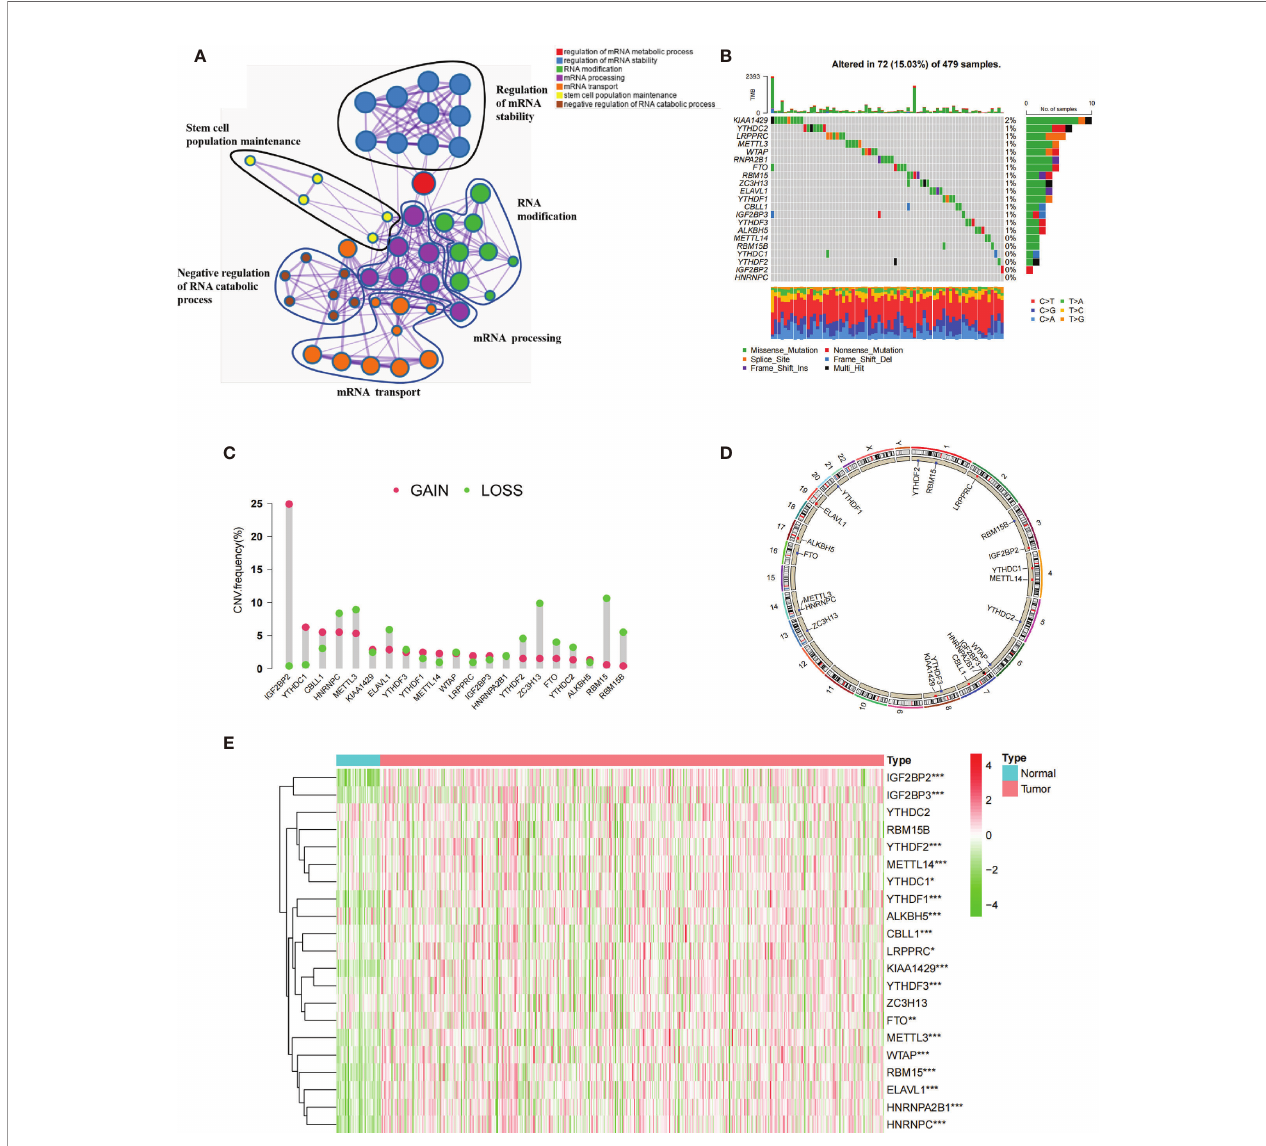
FIGURE 1 | The genetic landscape of 21 m 6 A regulators in HNSCC. (A) The functional enrichment network of 21 m 6 A regulators visualized by Metascape. Different circles represented different annotations. (B) Seventy-two of the 479 patients showed different genetic alterations, including missense mutation, splice site, and nonsense mutation. (C) The CNV of 21 m 6 A regulators. The column represented the alteration frequency. The green dots represented deletion of CNV. The pink dots represented ampli fi cation of CNV. (D) The location of CNV alteration of m 6 A regulators in cell. (E) The different expression level of 21 m 6 A regulators between normal and HNSCC (* p < 0.05; ** p < 0.01; *** p <